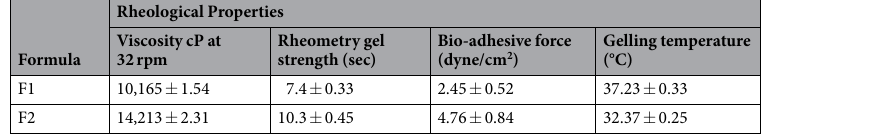
Table 2. Physicochemical properties of the different AuNPs thermoresponsive gels at 37